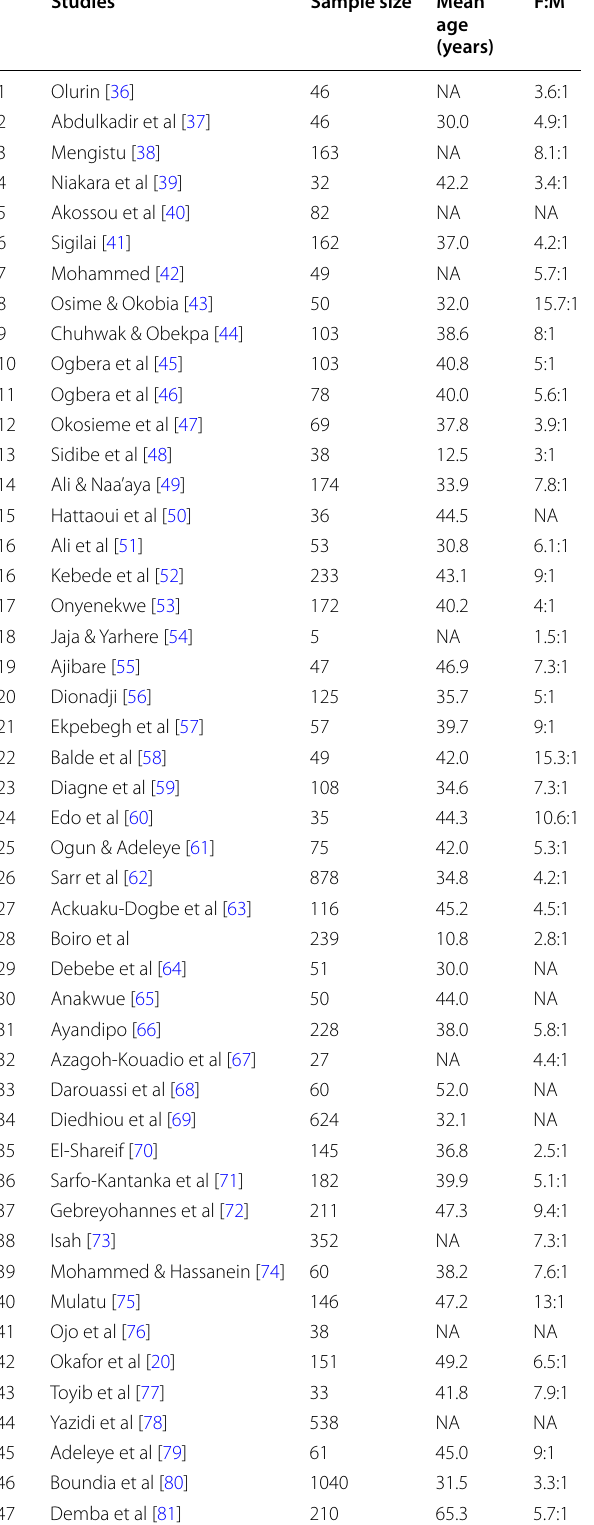
Table 4 Mean age and the sex ratio of the selected studies